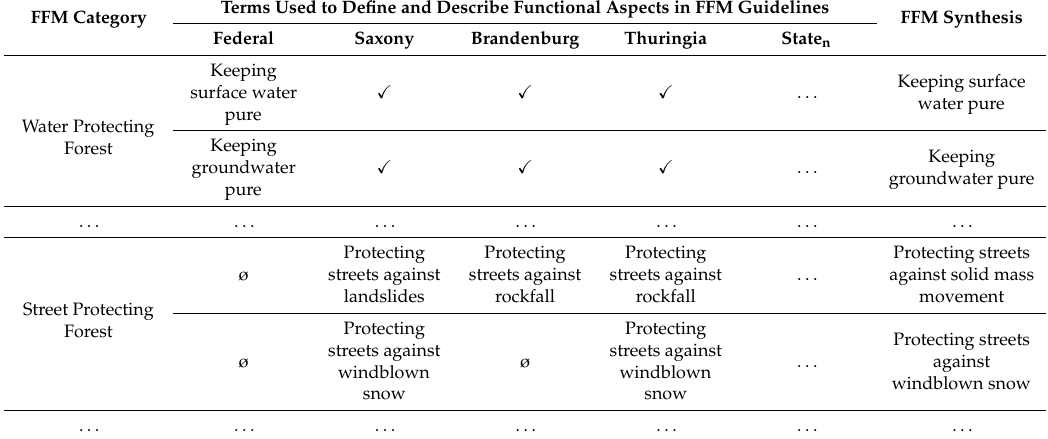
Table 1. Synthesis of state and federal forest function mapping (FFM) guidelines. Source: own representation. (cid:88) Same terms used; ø Terms not present.